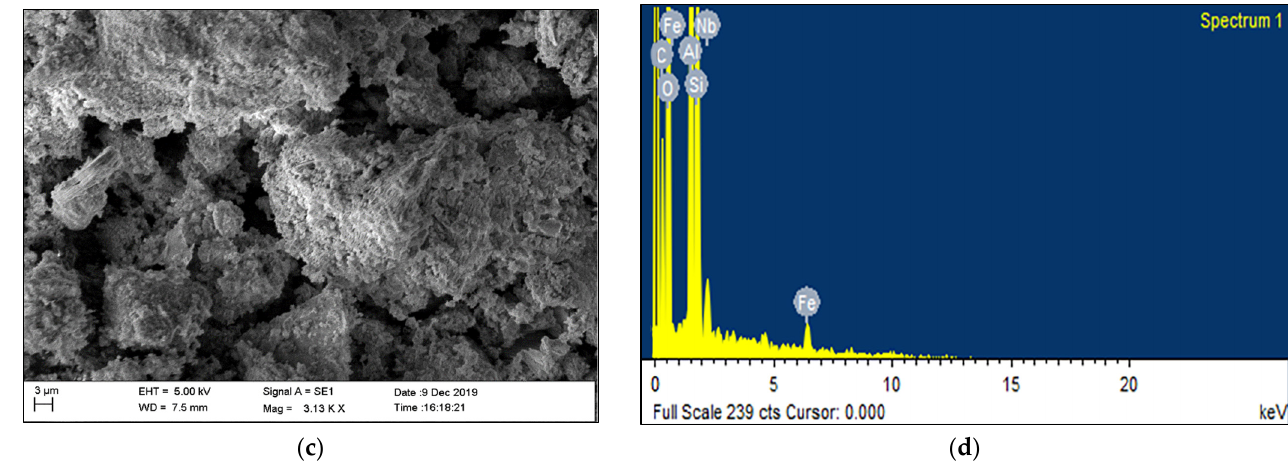
Figure 7. EDS analysis of Manipal sample; ( a ) elements weight (%), ( b ) atomic weight (%), ( c ) SEM image, ( d ) spectrum image.